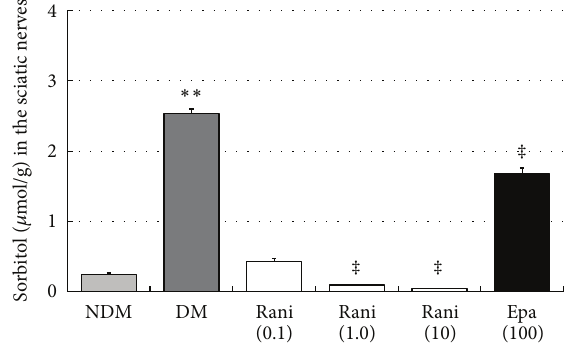
Figure 11: The sorbitol levels in the sciatic nerves at 15 weeks. The sorbitol level in the sciatic nerves in the untreated SDT rats is significantly higher that of the SD rats. ∗∗ 𝑃 < 0.01 , Student’s 𝑡 -test. The sorbitol levels in the sciatic nerves treated with ranirestat (1.0 and10 mg/kg/day)aresignificantlylowerthanthoseintheuntreated SDT rats. ‡ 𝑃 < 0.01 , Dunnett type joint-ranking test. The sorbitol level in the sciatic nerves treated with epalrestat is also significantly lower than in the untreated SDT rats. ‡ 𝑃 < 0.01 , Student’s 𝑡 -test. NDM: non-diabetes mellitus; DM: diabetes mellitus; rani: ranirestat; epal: